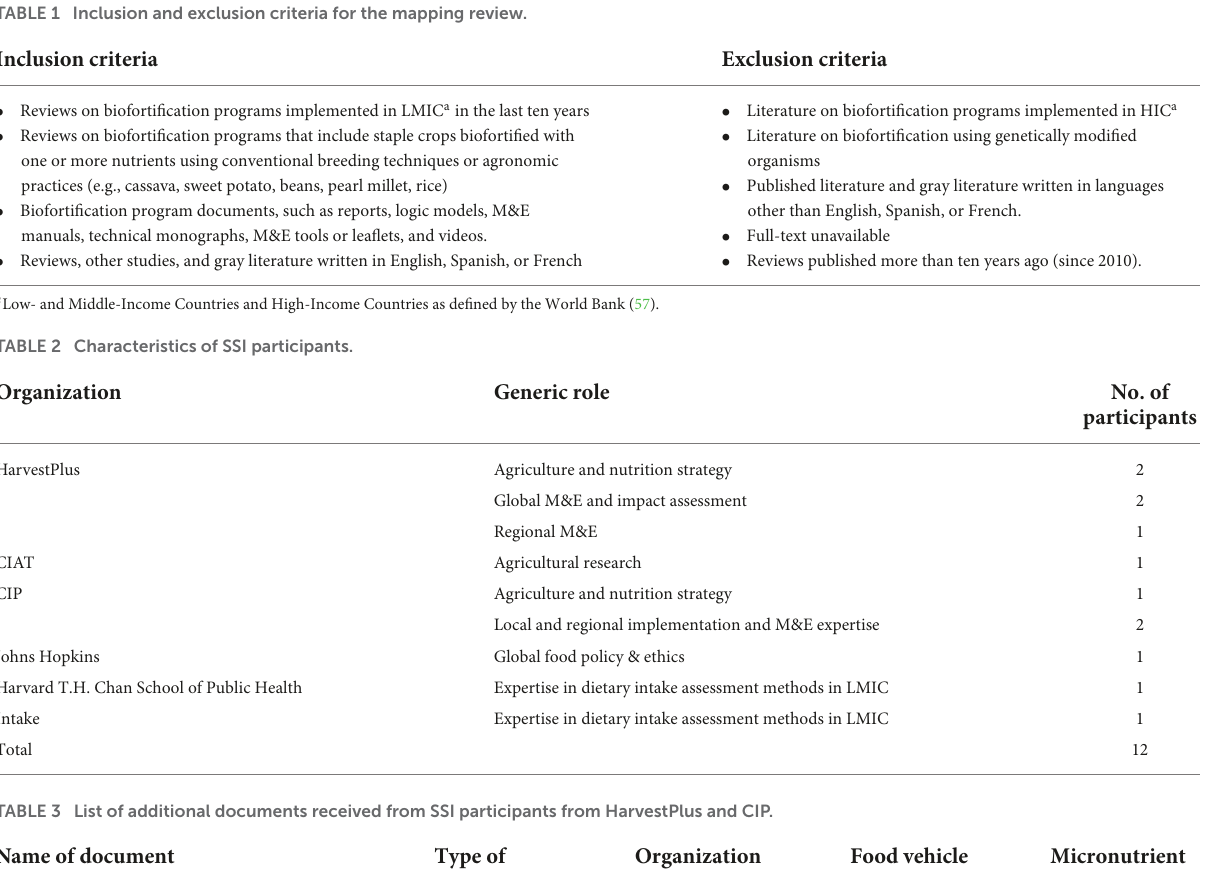
TABLE 1 Inclusion and exclusion criteria for the mapping review.